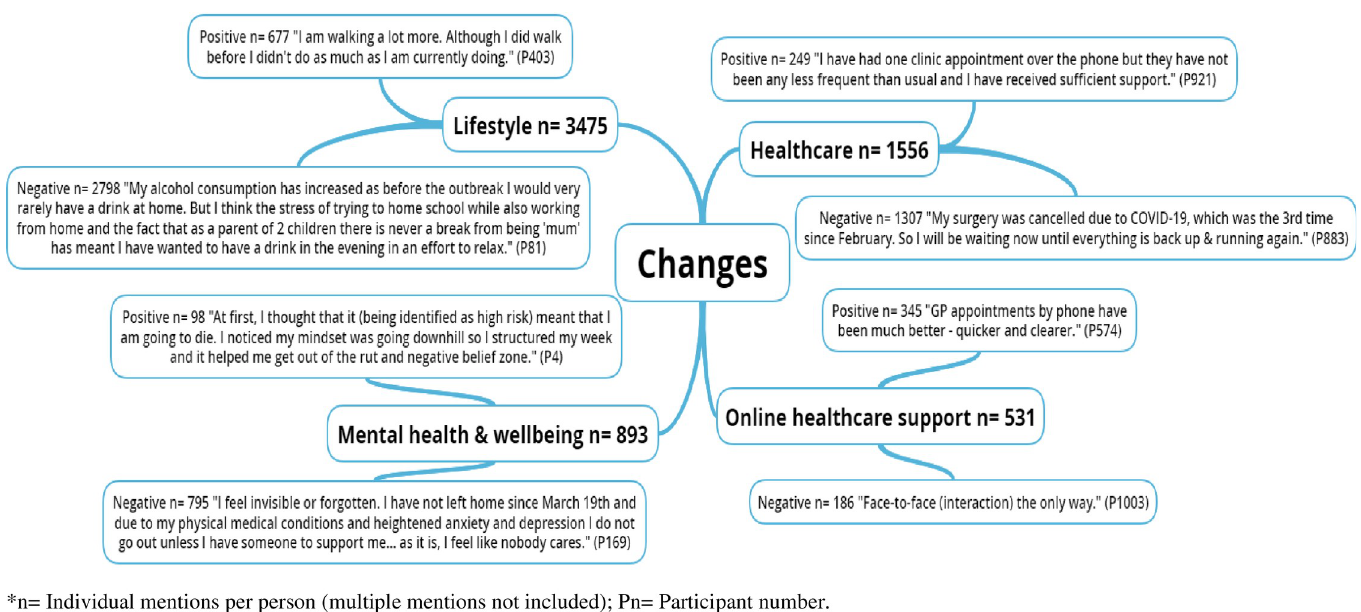
Fig 4. Exploring the changes of UK adults at high risk of severe illness during the COVID-19 lockdown.